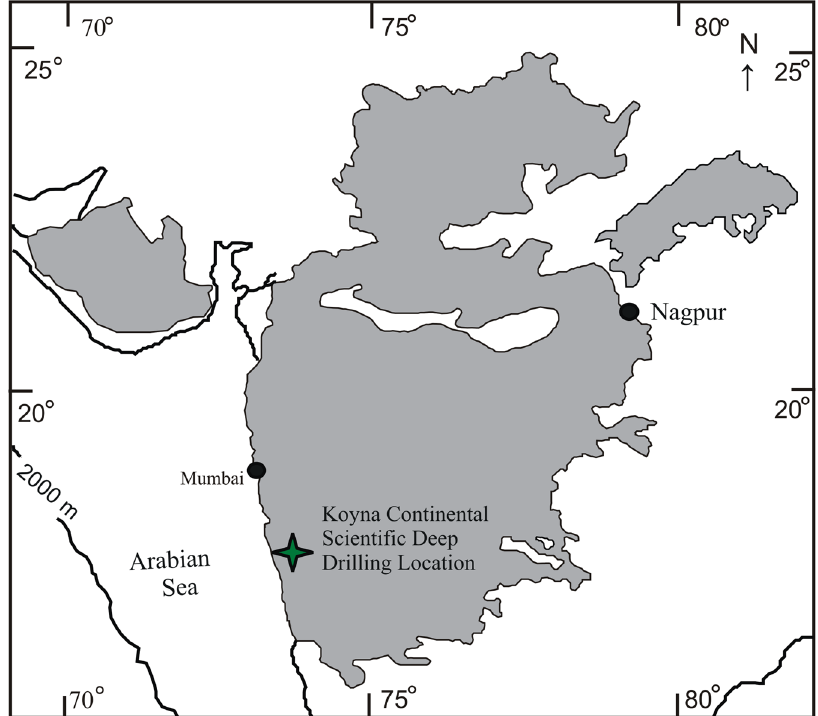
Figure 1. Geological map showing areal spread of the Deccan flood basalt eruptions and location of the Koyna Continental Scientific Deep Drilling Project drill hole (KBH-7) of this